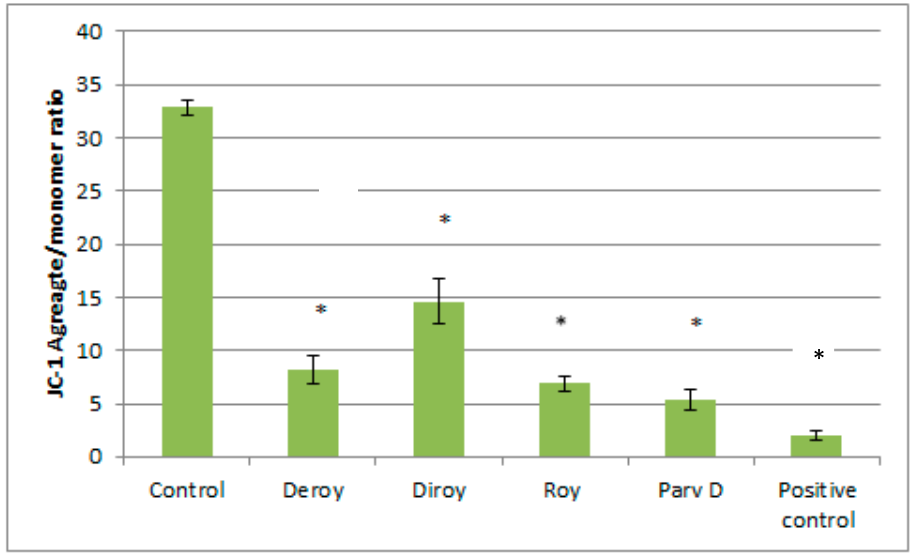
Figure 6. The effect of Deroy, Diroy, Roy, and Parv D on mitochondrial membrane potential in primary H7PX glioma cells. MMP is expressed as a ratio of 530 nm/590 nm to 485 nm/538 nm (aggregates to monomer) fluorescence, as quantified with a fluorescent plate reader after JC-1 staining. The data represent means ± SD. * P < 0.05 Control vs. Deroy, Diroy, Roy, and Parv D. Temozolomide was used as a positive control.